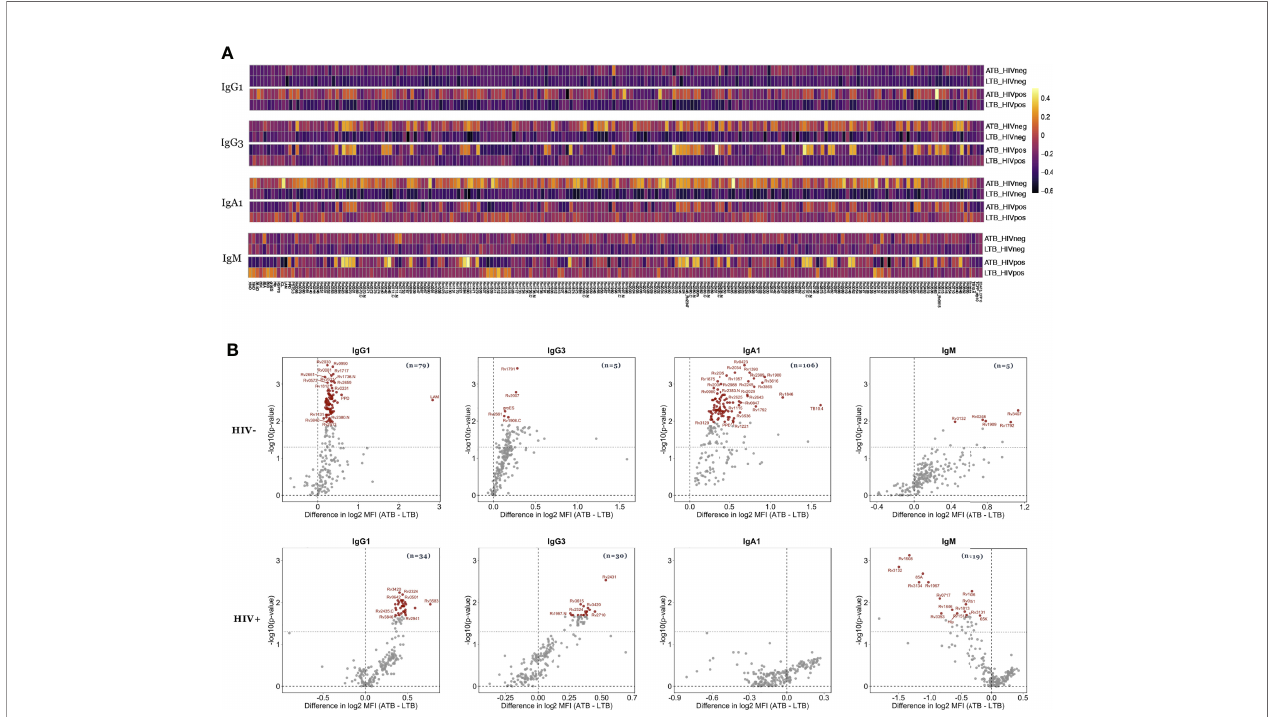
FIGURE 2 | Mtb-speci fi c antibody levels differ between ATB and LTB in HIV negative and HIV positive populations. Relative levels of IgG1, IgG3, IgA1 and IgM against 209 Mtb antigens were quanti fi ed via Luminex in the plasma of ATB (n=21) and LTB (n=22) patients in the HIV negative group and ATB (n=12) and LTB (n=22) patients in the HIV positive group. (A) Heatmaps illustrate the median of Z-scored MFI data for each group indicated. (B) The volcano plots characterize the magnitude (log2 fold change of ATB/LTB) and the signi fi cance ( p values) of antibody levels between ATB and LTB. Values above black dashed lines are statistically different between ATB and LTB ( p < 0.05). For adjusted p values, signi fi cant data are shown in red, non-signi fi cant differences are in